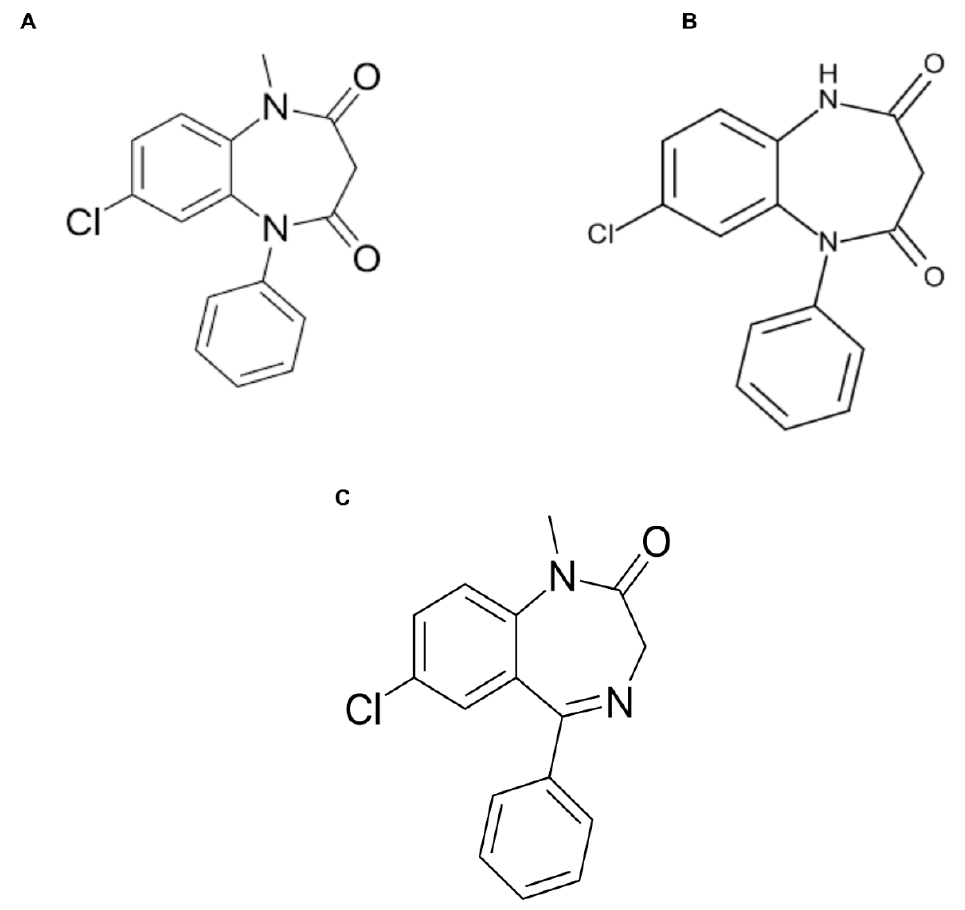
Figure 1. Chemical structures of ( A ) clobazam (CLB); ( B ) the metabolite N -desmethylclobazam (NDMCLB); and ( C ) the internal standard used (diazepam).